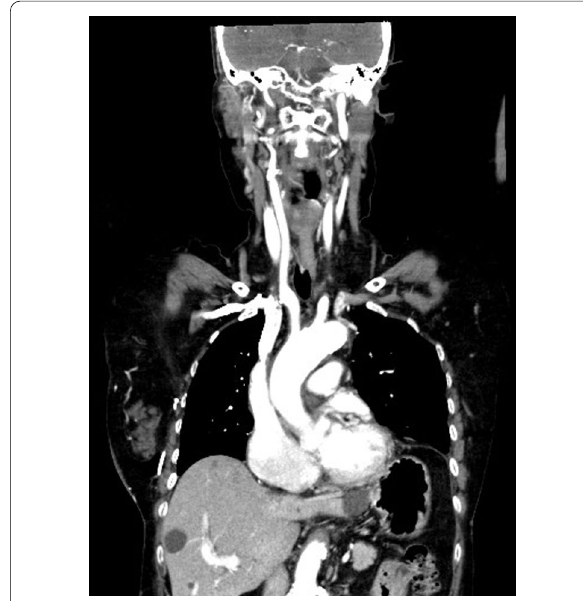
Fig. 3 Postoperative contrast-enhanced computed tomography shows no mass in the superior vena cava or right atrium